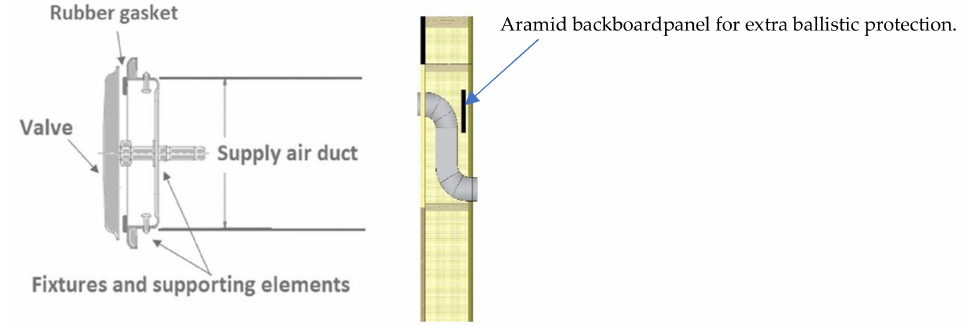
Figure 3. Possible solutions for built-in ventilation systems with additional ballistic protection and smoke leakage.